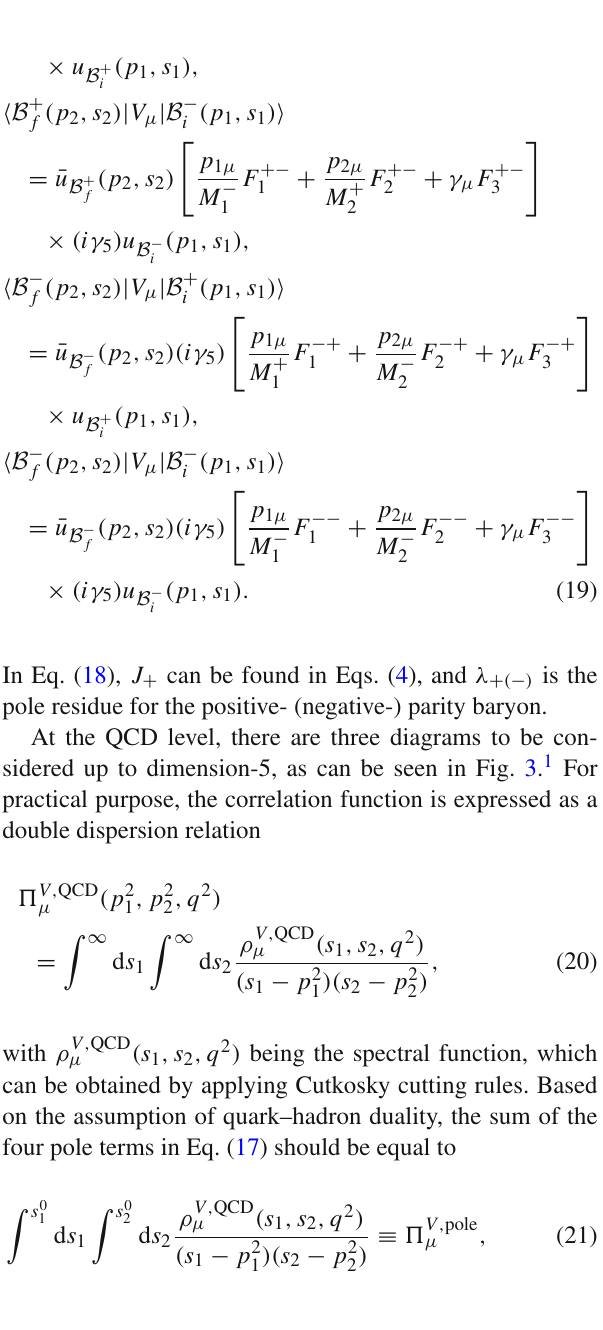
Fig. 2 Only three nonzero diagrams survive for the two-point correlation function of (cid:2) Q , if we consider the contributions up to dimension-5 and neglect those from dimension-4. The double lines denote the heavy quarks and the dots stand for the condensates